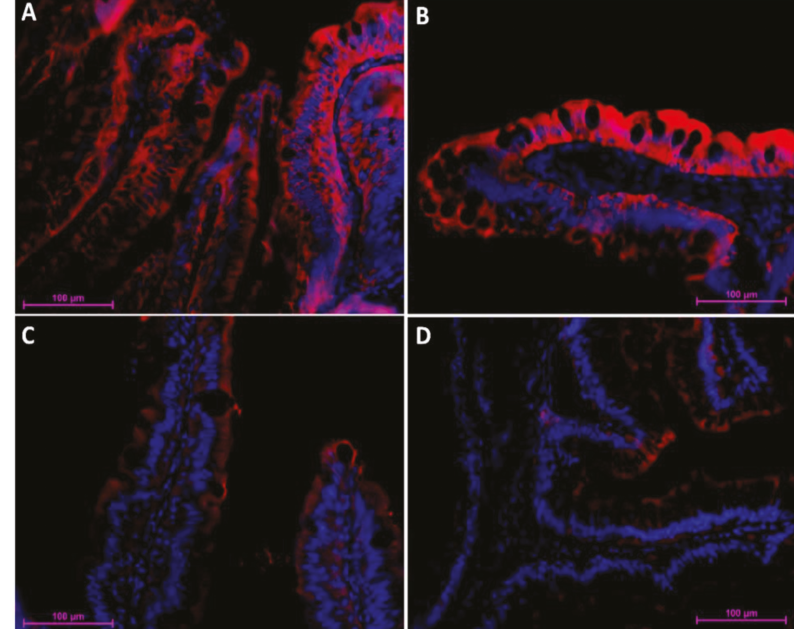
Figure 6. Immunofluorescent localization of fatty-acid-binding protein 2 (Fabp2) along the rainbow trout (RT) intestine (red signal). The signal was most intense in the first segment of the mid-intestine ( A ) and in the apical part of the complex folds ( B ), was intermediate in the pyloric caeca ( C ), and was lowest within the basal part of the complex folds and in the rest of the second segment of the mid-intestine ( D ). In summary, cell type distribution and brush border functional protein expression followed the same pattern in the first portion of the mid-intestine and the apical part of the complex folds of the second portion. On the contrary, functional protein expression did not match the cell distribution pattern between pyloric caeca and the rest of the second portion of the distal intestine. Results are